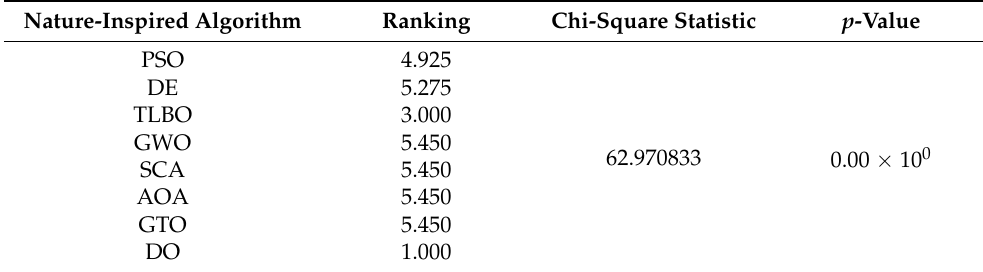
Table 9. Friedman test for multiple comparisons between DO and other nature-inspired algorithms when optimizing the delamination size at the bottom side.